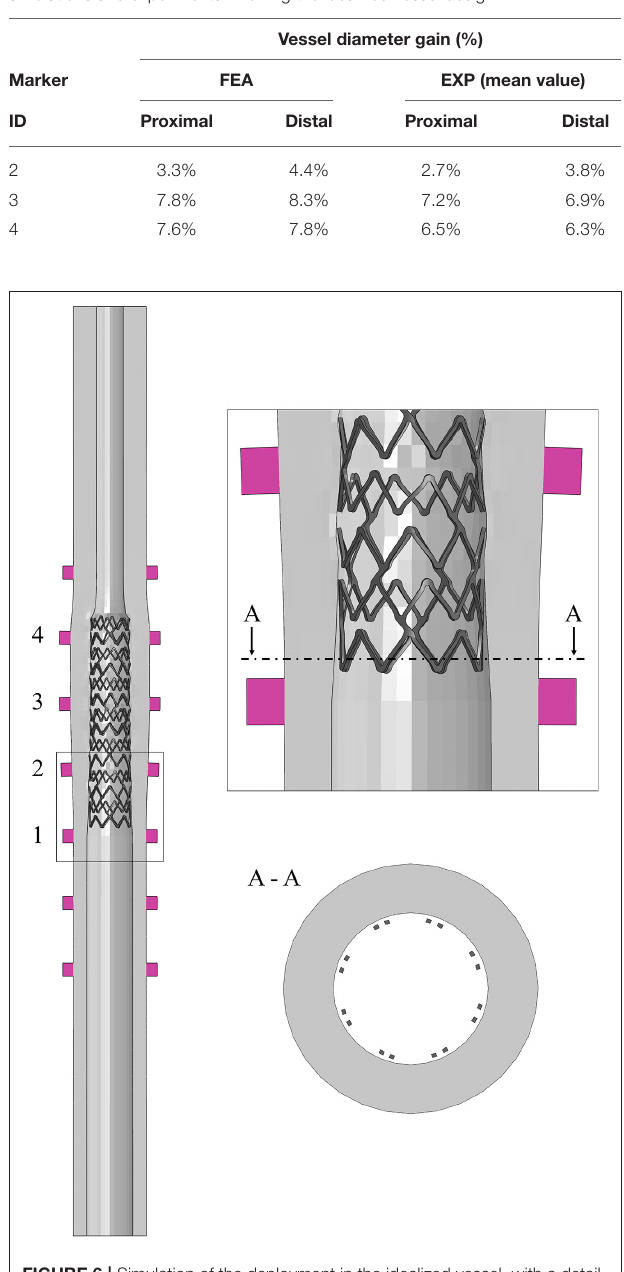
FIGURE 6 | Simulation of the deployment in the idealized vessel, with a detail of the struts malapposition in correspondence to Marker